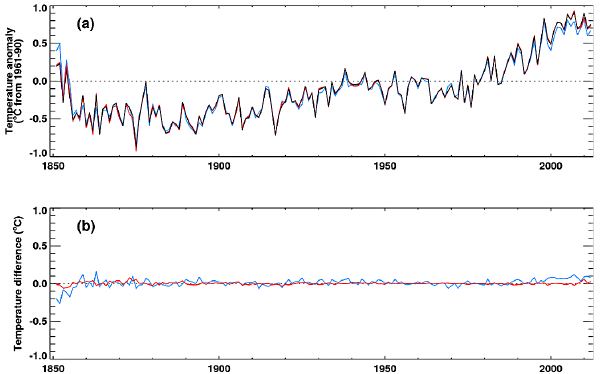
Figure 1. Annual and global mean land air temperatures anomalies calculated using three approaches: (1) form monthly hemispheric means, then annual means, then global means weighted by land area in each hemisphere (black); (2) form annual grid-box means, then hemispheric means, then global means weighted by land area in each hemisphere (red); (3) form hemispheric means, then annual means, then global means of equally-weighted hemispheres (blue). The three results are compared in (a) , and di ff erences [red = (1)– (2), blue = (1)–(3)] are shown in (b) with the same vertical scale as in (a)